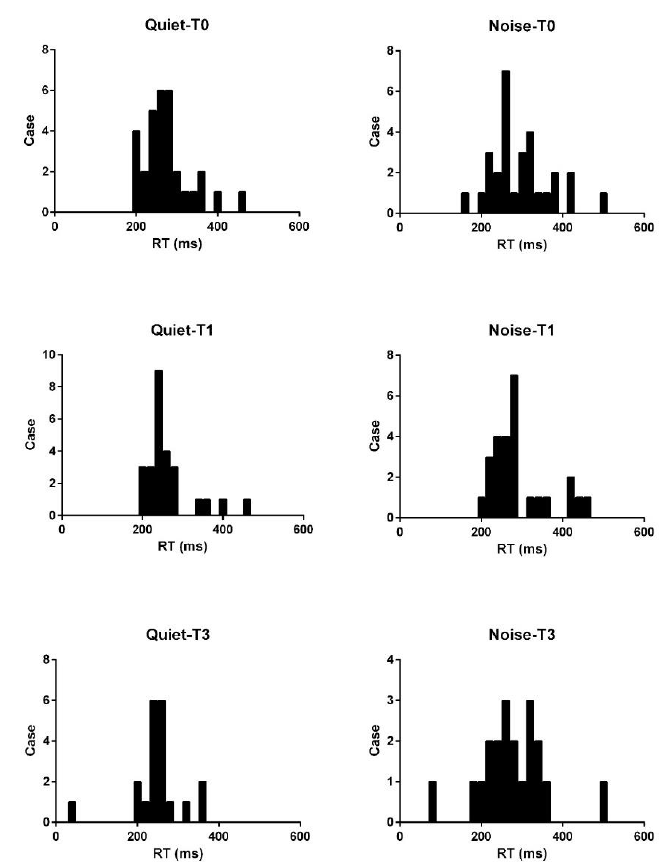
Figure A4. Histograms of reaction time (RT) distribution in quiet and noisy conditions before treatment (T0), 1 month after treatment (T1) and 3 months after treatment (T3).